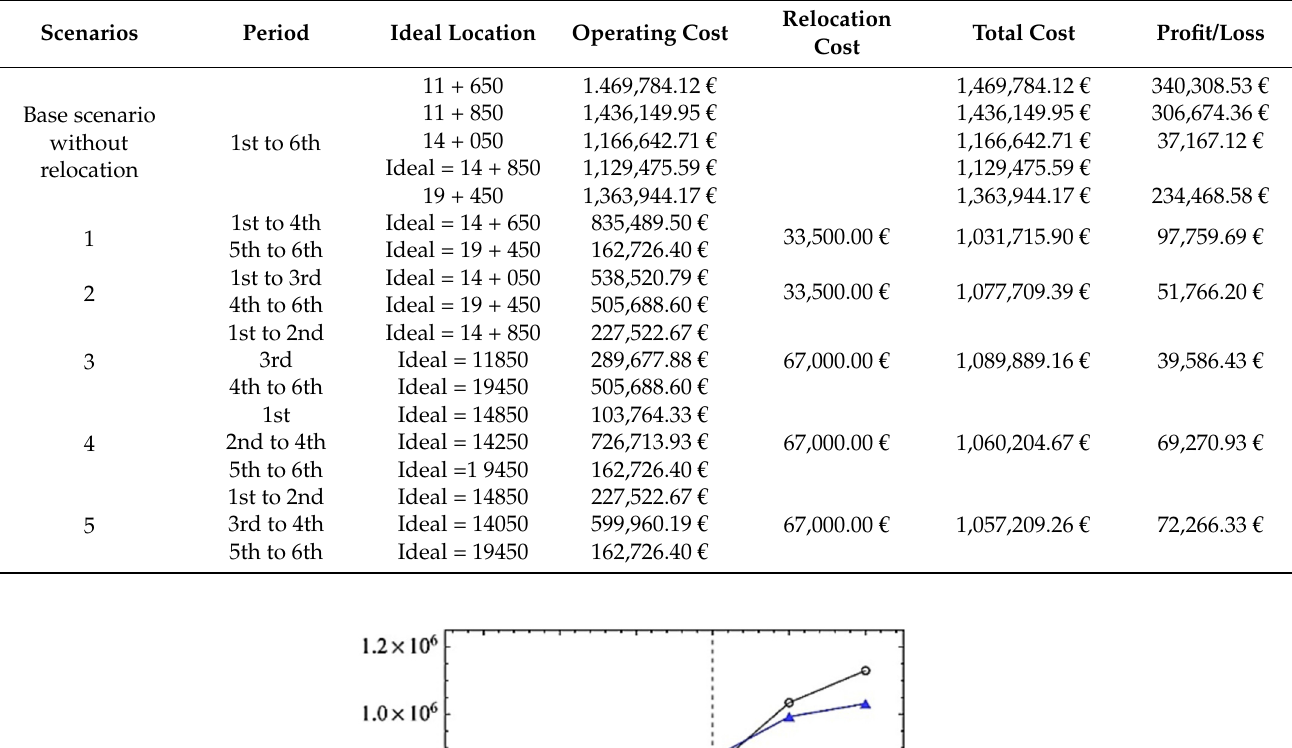
Table 6. Operating costs results of the second project.